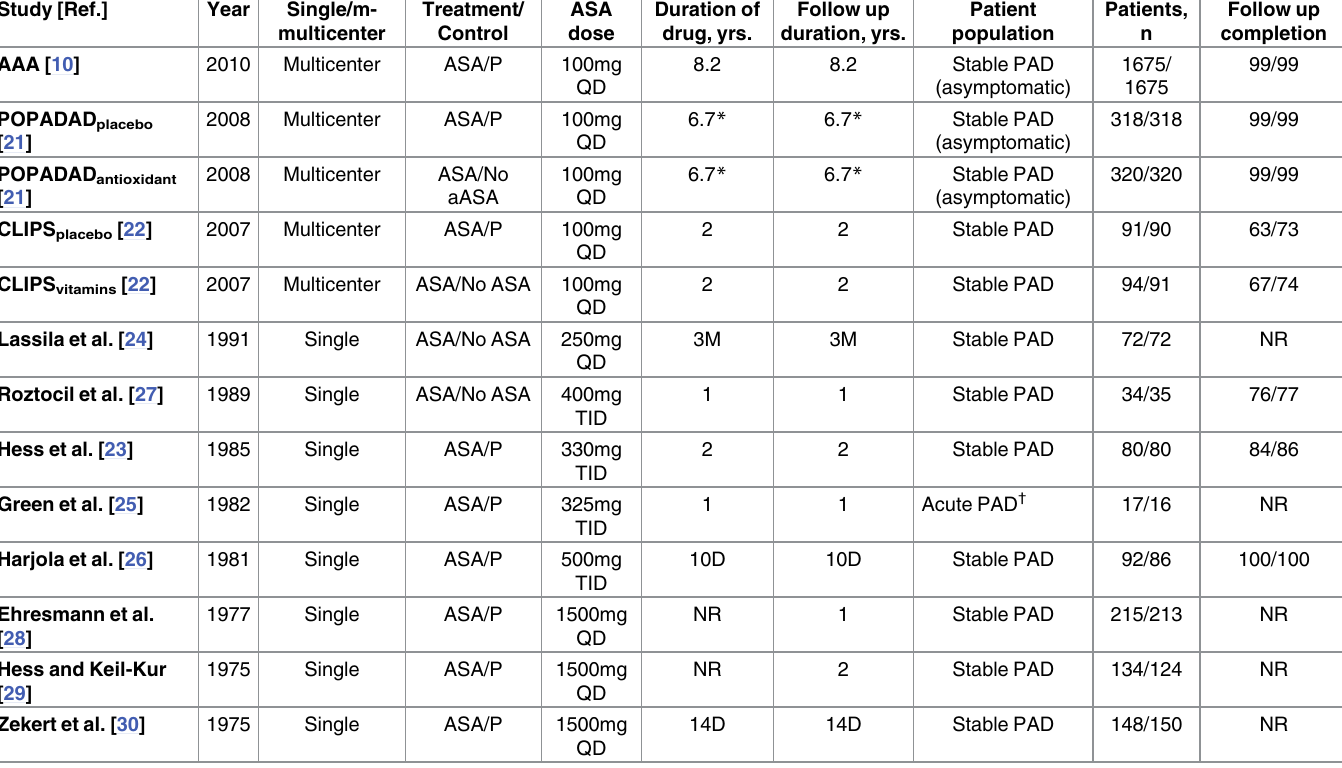
Table 1. Baseline study characteristics. Study